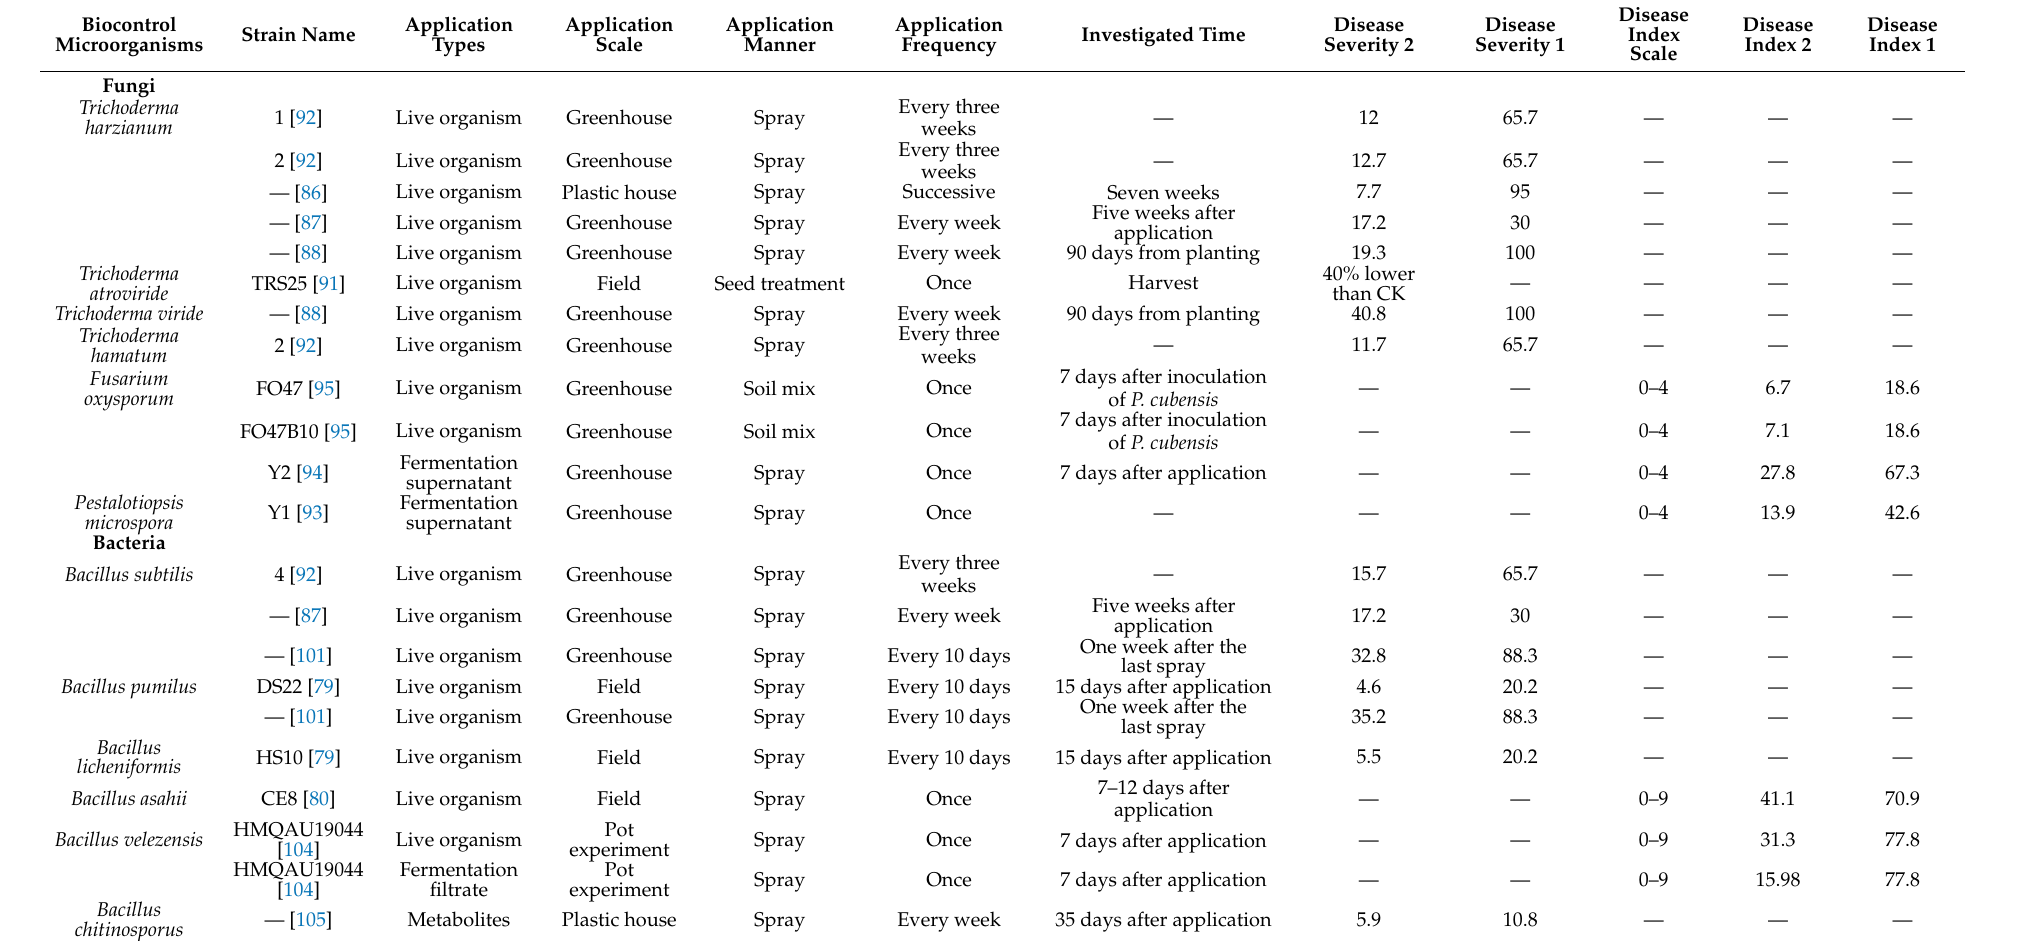
Table 1. Overview of biocontrol agents showing control ability against cucumber downy